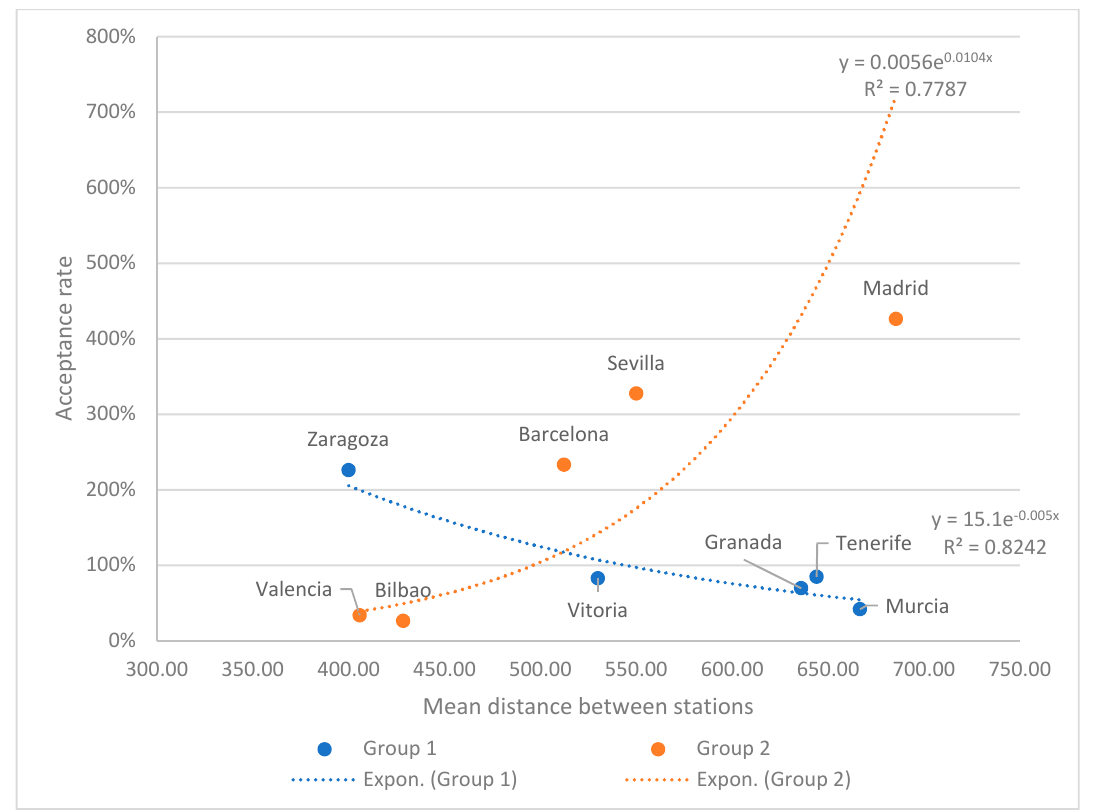
Figure 6. Relationship between acceptance rate and mean distance between stations for Groups 1 and 2.